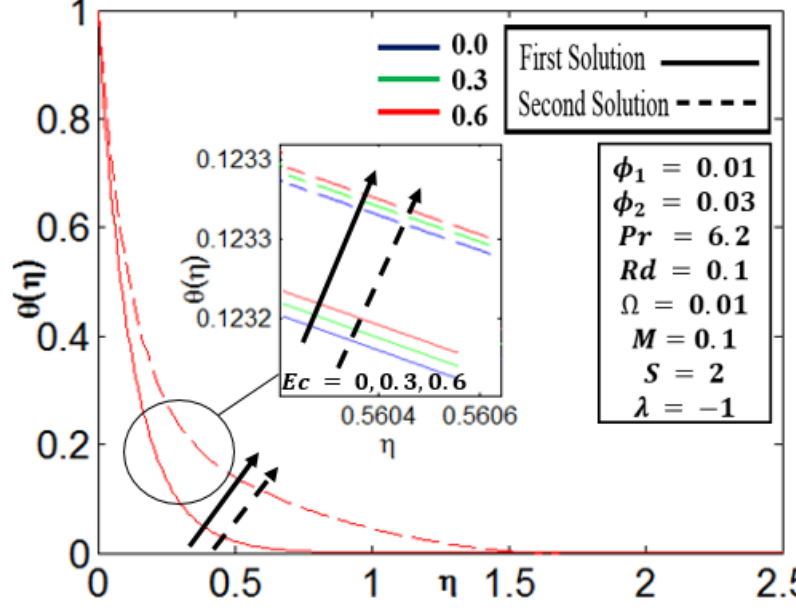
Figure 6. Profile of 𝜃(𝜂) for different 𝐸𝑐 parameters.